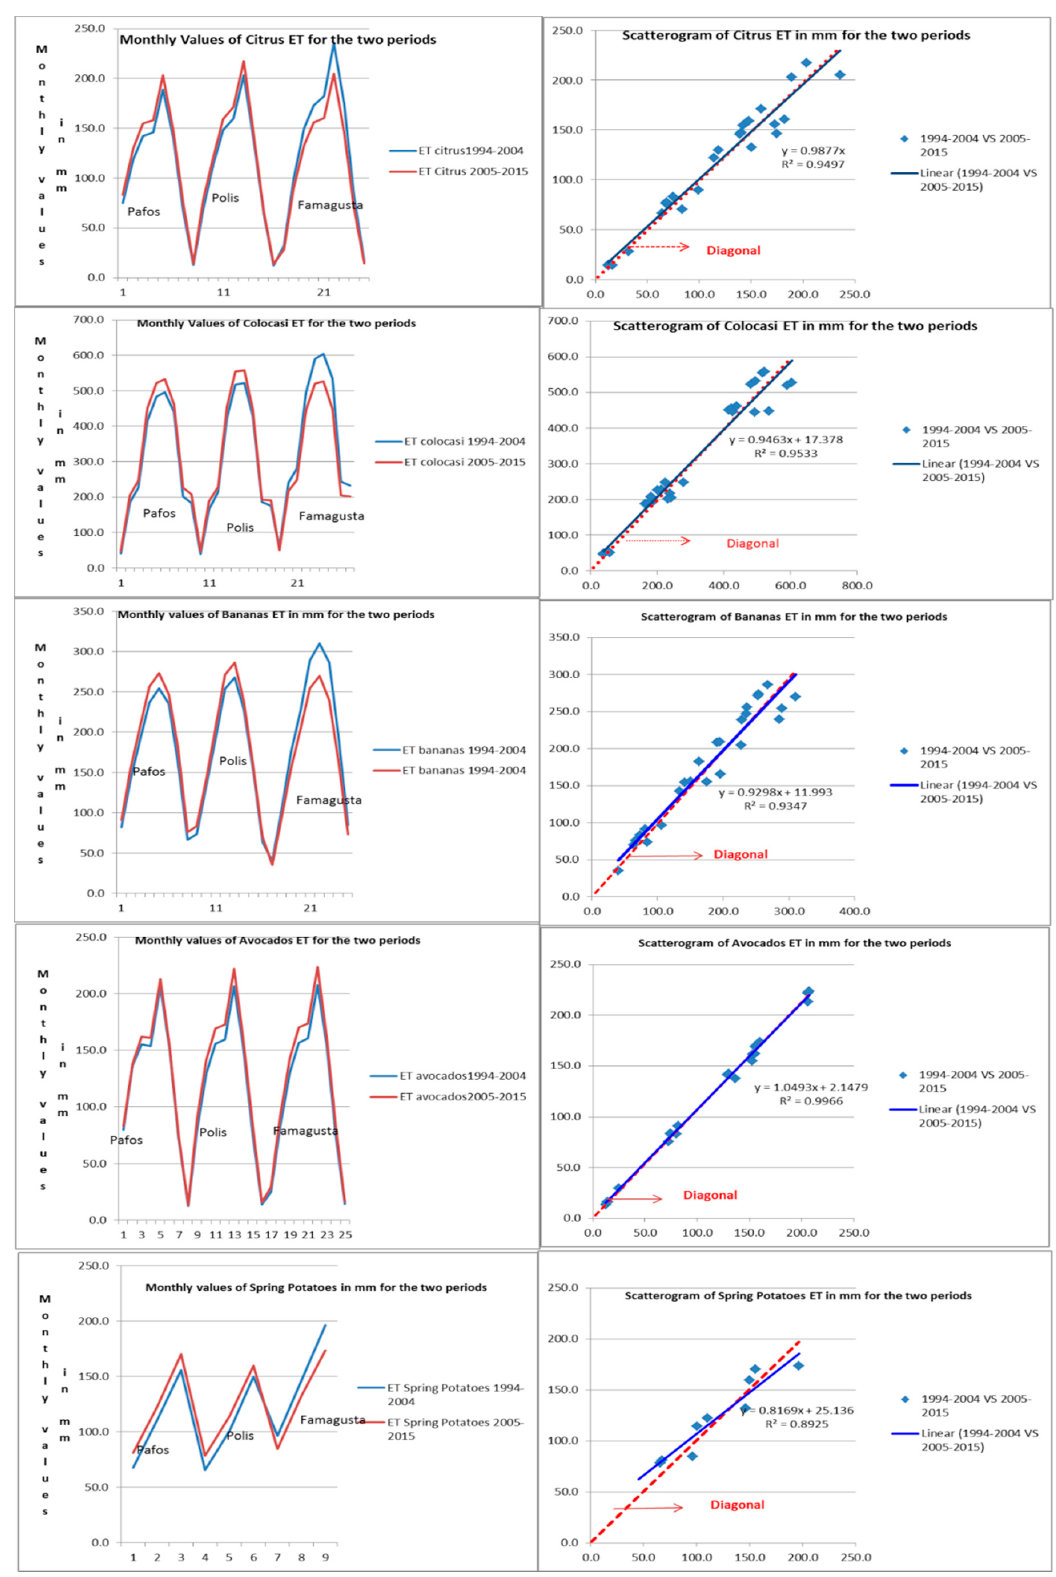
Figure 6. Results of the SEBAL application for the five crops.